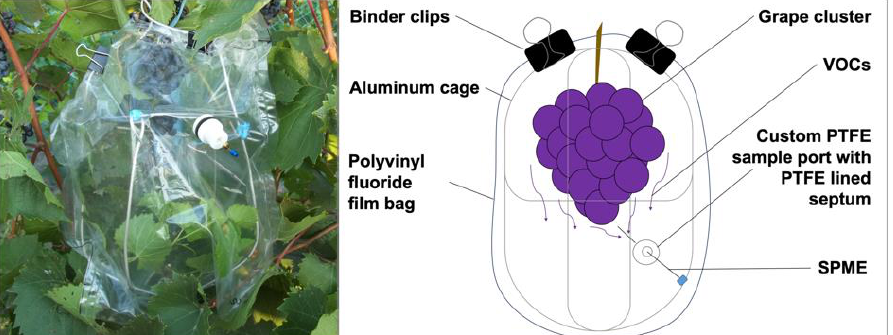
Figure 1. Non-destructive sampling of biogenic volatiles emitted by the whole cluster of grapes on a vine. Schematic of polyvinyl fluoride (PVF) film chambers used for short-term enclosing of growing clusters of cold-hardy grapes during in-vivo sampling of volatile emissions using solid-phase microextraction (SPME). An aluminum wire cage was constructed to hold the PVF chamber spread around and to be secured to the grape vine’s training system. The PVF chamber was modified with a custom polytetrafluoroethylene (PTFE) port fitted with 11 mm PTFE lined silicone septa (SPME sampling port).